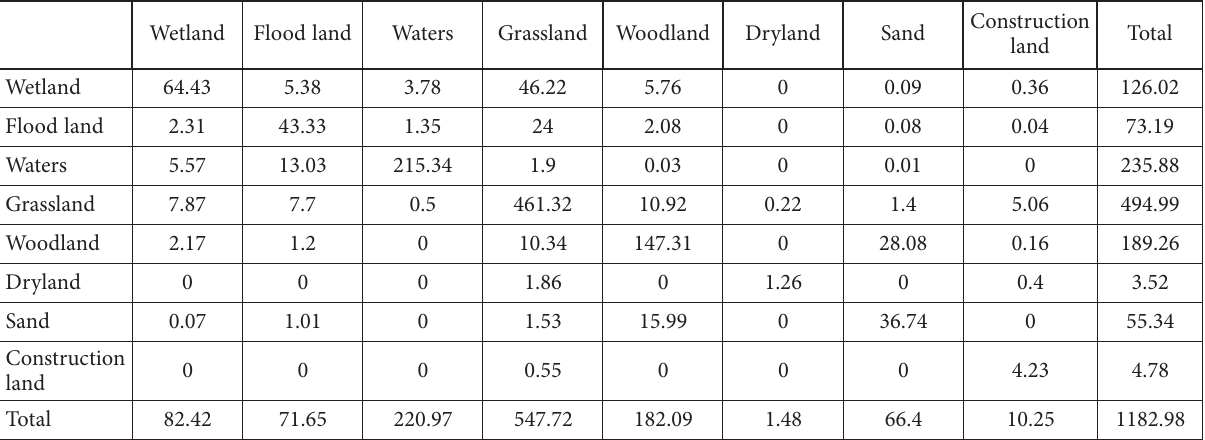
Table 2. Area transfer matrix of Dalinor land use from 1985 to 2015 (km 2 ) Wetland Flood land Waters Grassland Woodland